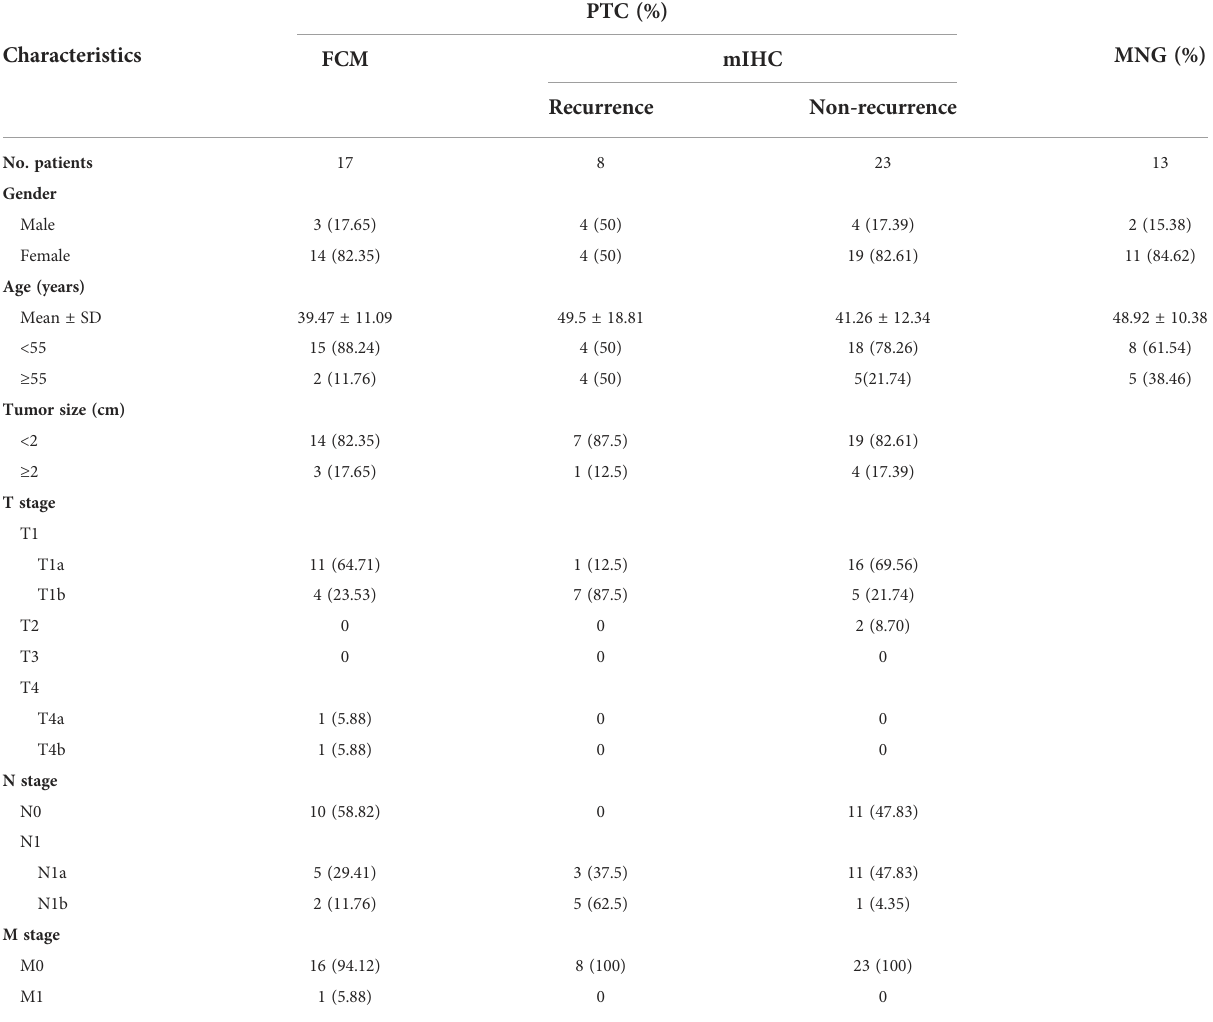
TABLE 1 Demographics and clinicopathologic characteristics of PTC patients.